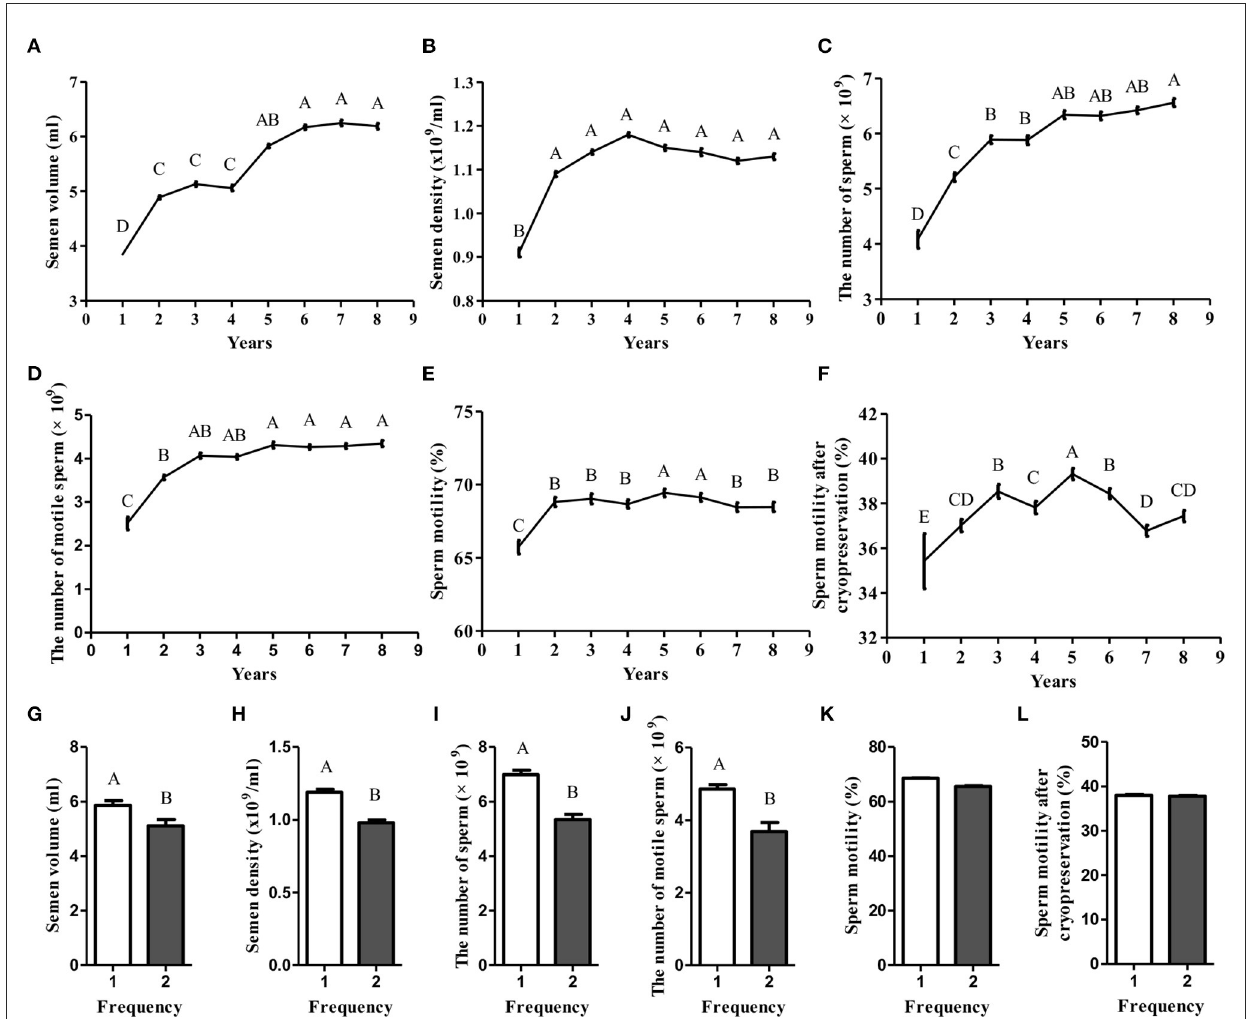
FIGURE1 The effect of age and collection frequency affecting semen quality. (A–F) The effect of age on semen volume, semen density, the number of sperm, the number of motile sperm, sperm motility, and sperm motility after cryopreservation; (G–L) The effect of collection frequency on semen volume, semen density, the number of sperm, the number of motile sperm, sperm motility, and sperm motility after